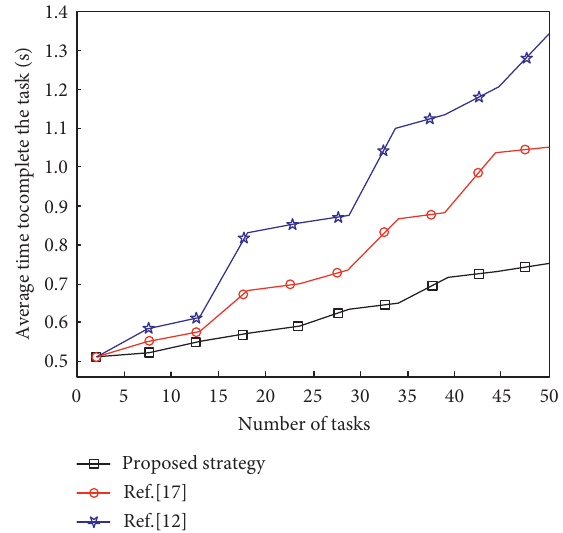
Figure 5: The average time for different algorithms to complete tasks under different number of